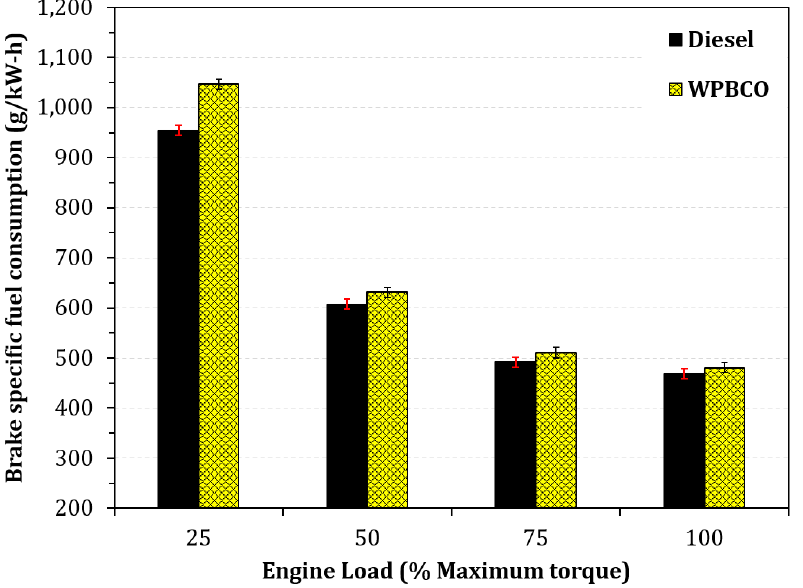
Figure 5. Variation in brake-specific fuel consumption with respect to the engine load.